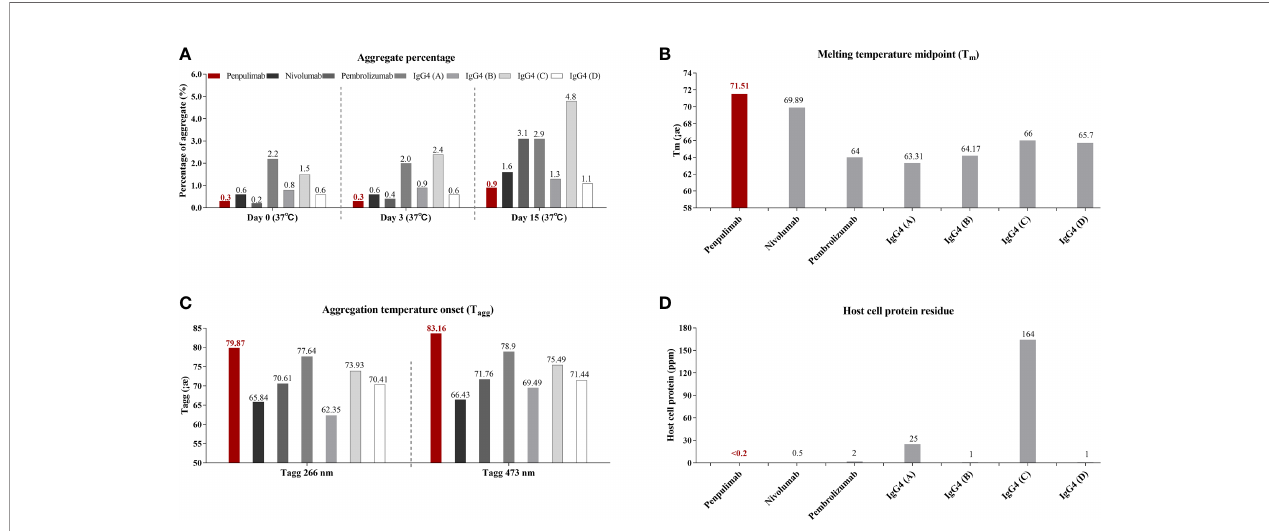
FIGURE 1 | (A) Aggregates tested by size exclusion chromatography (SEC), (B) melting (Tm) and (C) aggregation temperature (Tagg) characterization using dynamic light scattering (DLS) and static light scattering (SLS), respectively, and (D) Host-cell protein (HCP) residue assay in penpulimab and other IgG4 backbone anti- PD1